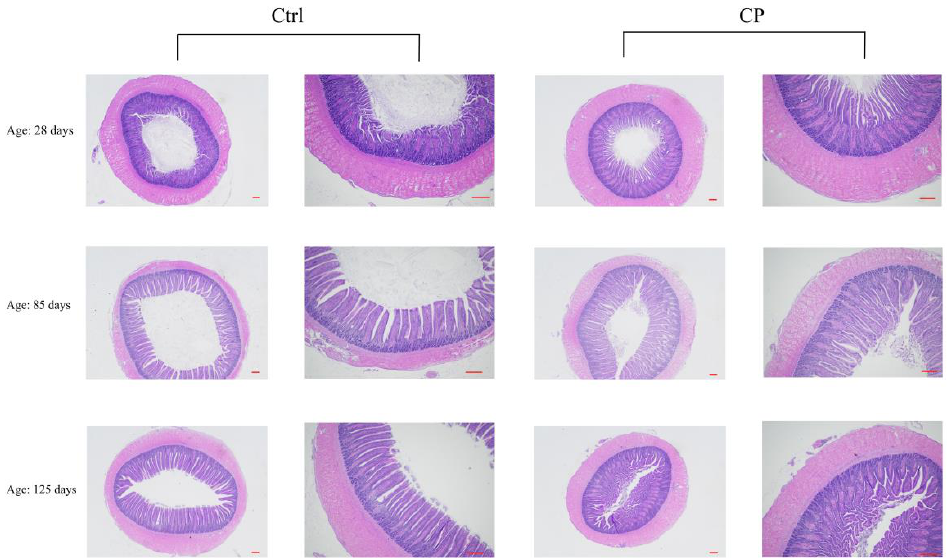
Figure 3. Effects of compound probiotics on the morphological structure in the ileum mucosa of ducks. Ctrl, basal diet, CP, basal diet supplemented with 0.15% compound probiotics. The first and third columns of the pictures are scaled to 100 µm, and the second and fourth columns of the pictures are scaled to 50 µm.